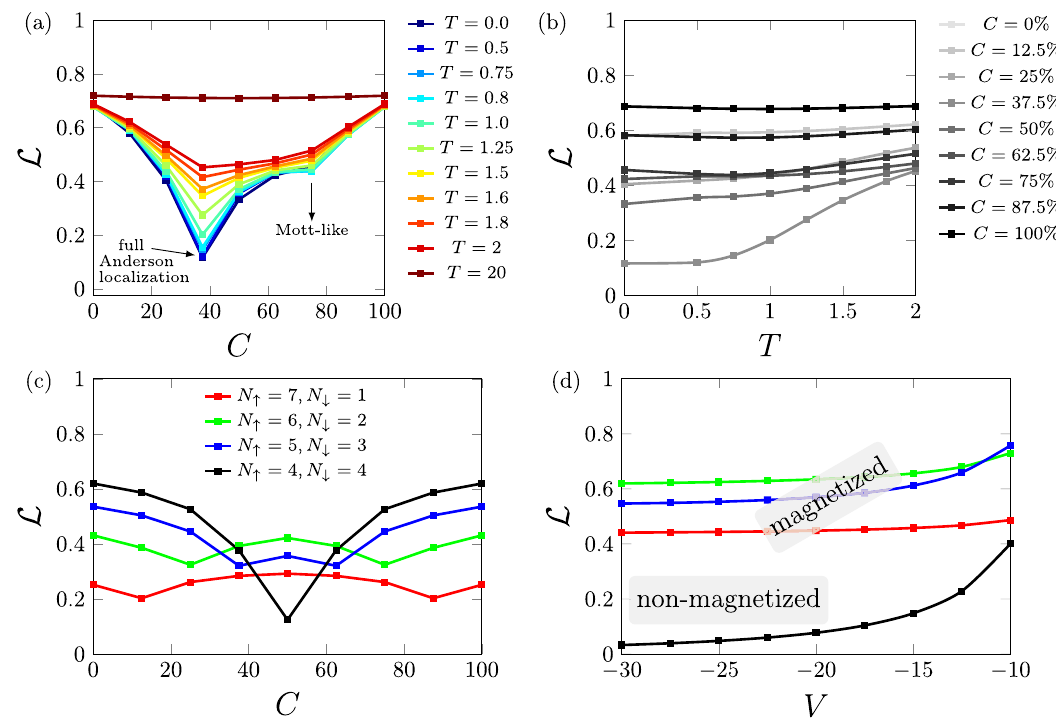
Figure 3. ( a ) Entanglement as a function of the concentration of impurities for several temperatures for n = 0.75 . ( b ) Entanglement as a function of the temperature for several concentrations for n = 0.75 . ( c ) Entanglement as a function of concentration for several magnetizations m = n ↑ − n ↓ for n = 1.0 . In all cases L = 8 , U = 5 t and V = − 10 t